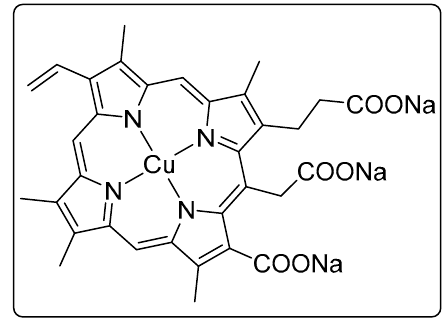
Figure 1. The structure of sodium copper chlorophyllin (SCC; C 34 H 31 CuN 4 Na 3 O 6 ).